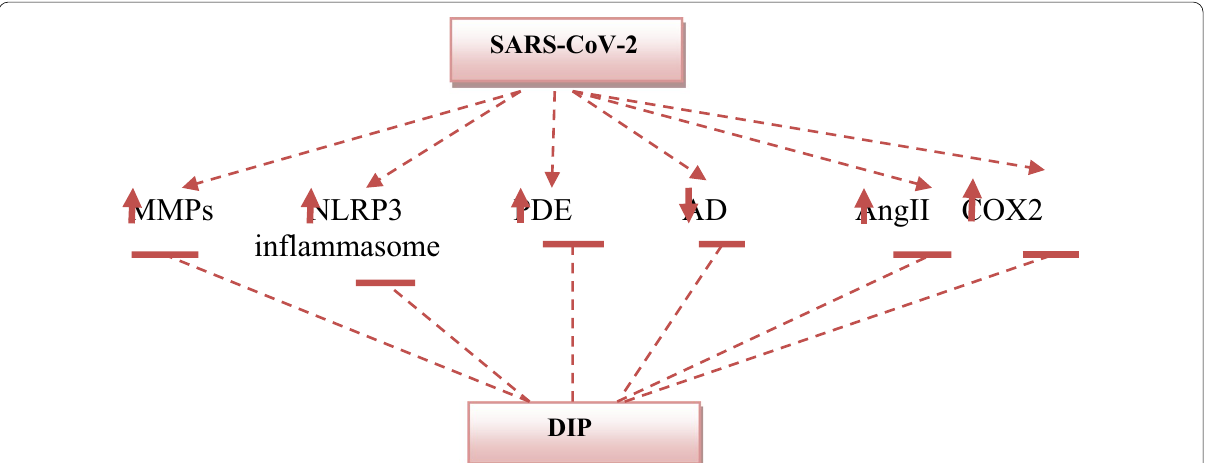
Fig. 2 Effects of DIP in Covid‑19. Infection with SARS‑CoV‑2 augments MMPs, COX‑2, NLRP3 inflammasome, PDE, and AngII with reduction of AD. DIP inhibits SARS‑CoV‑2‑mediated inflammatory